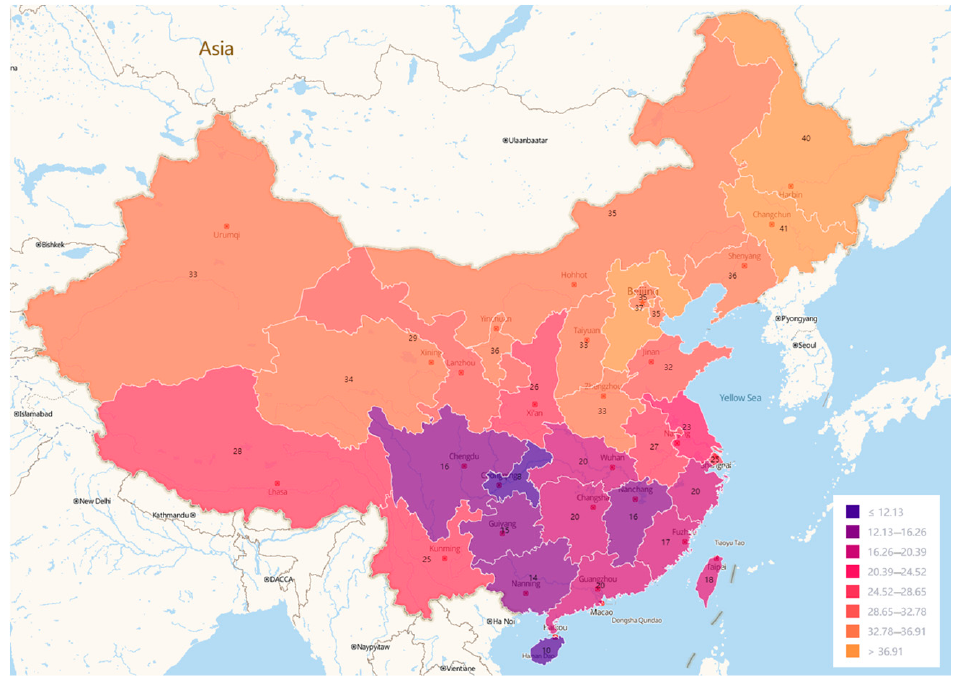
Figure 4. Map showing the average value of the optimal tilt angle for PV application in China. This does not represent a complete map of the country.